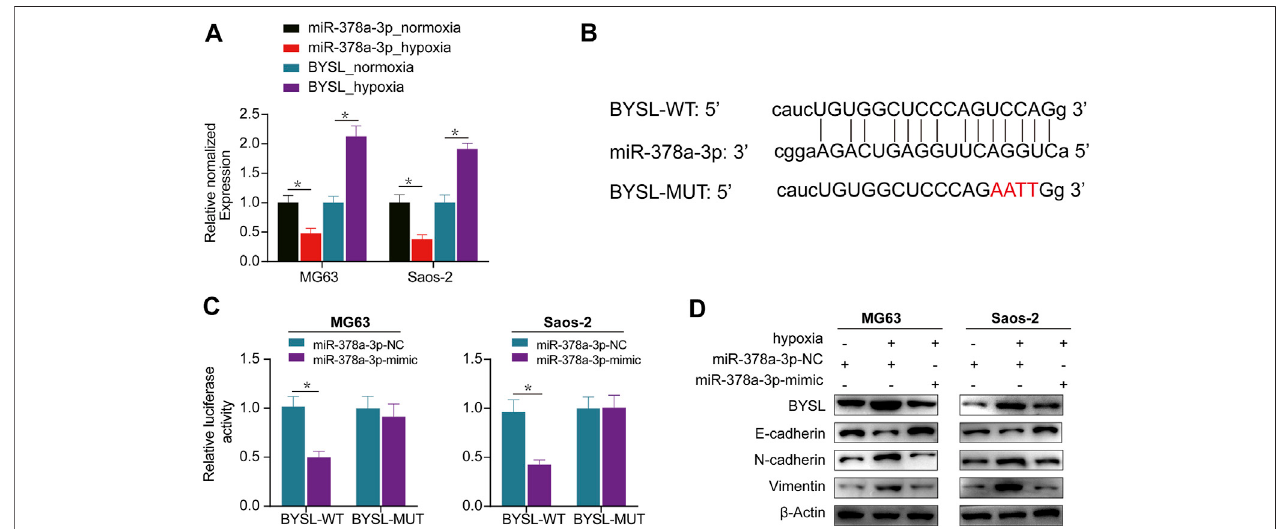
FIGURE 2 | BYSL isadirecttargetofmiR-378a-3p. (A) MG63andSaos-2cellswereculturedunderhypoxicornormoxicconditions.TheRNAlevelsofmiR-378a-3pand BYSLweremeasuredbyRT-qPCR. (B) The3 ′ -untranslatedregion(UTR)of BYSL harborpotentialmiR-378a-3pbindingsites. (C) Theluciferaseactivitydisplayedbytheluciferase reporter constructswhich contained wild-type(WT)ormutant(MUT) 3 ′ -UTRof BYSL wereco-transfected with miR-378a-3p mimicinto MG63and Saos-2cells. (D) MG63and Saos-2cellsweretransfected withcontrol-mimic(miR-378a-3p-NC) or miR-378a-3p-mimic,andthenculturedunderhypoxicornormoxicconditions. Theproteinlevelsof BYSL, E-cadherin, N-cadherin, and Vimentin were measured by western blot. The data are presented as the mean ± SD. * p < 0.05.